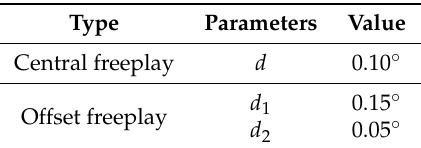
Figure 6. The finite element model of the all movable fin and elastic beam. Table 2. The parameters of